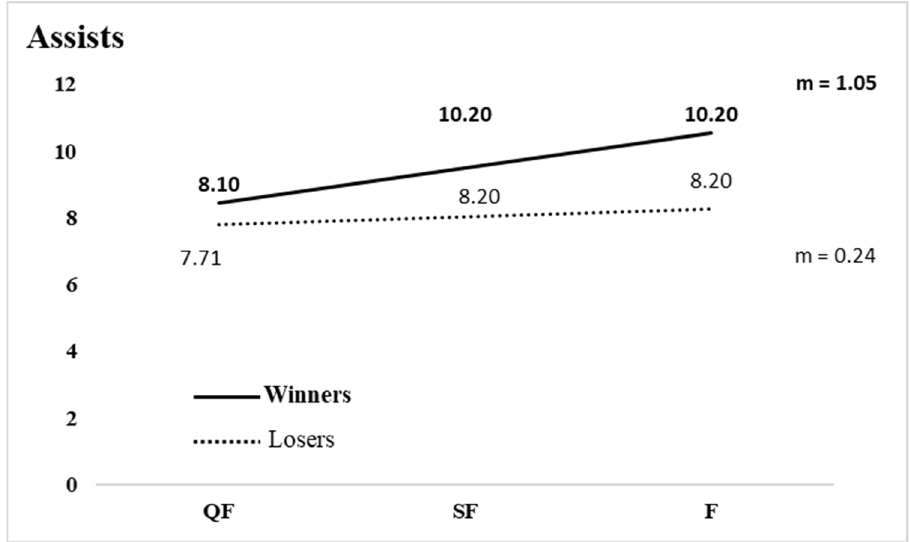
Figure A1. Linear tendency lines of assists performed in matches. Note: QF = Quarterfinals; SF = Semifinals; F = Finals.